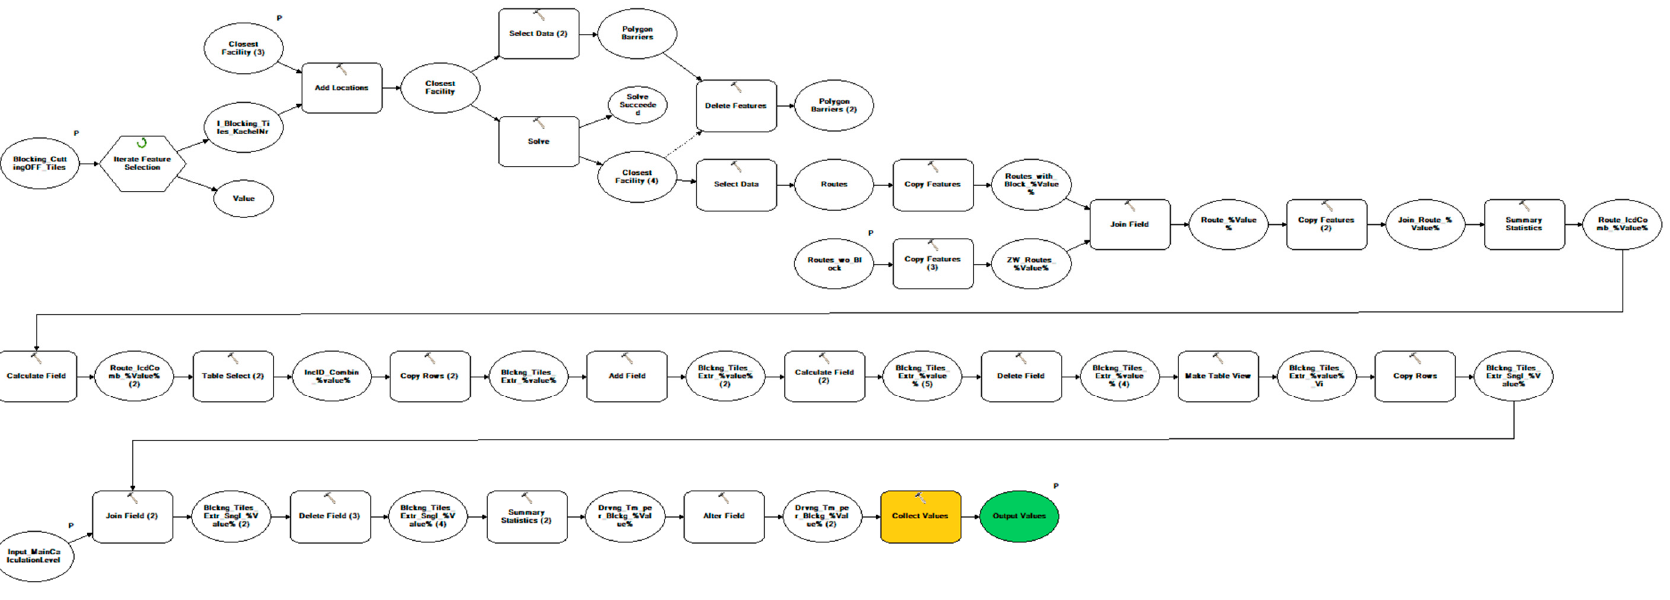
Figure A7. Iterations in the Addition of isolated/cut off tiles level in ArcMap ModelBuilder.